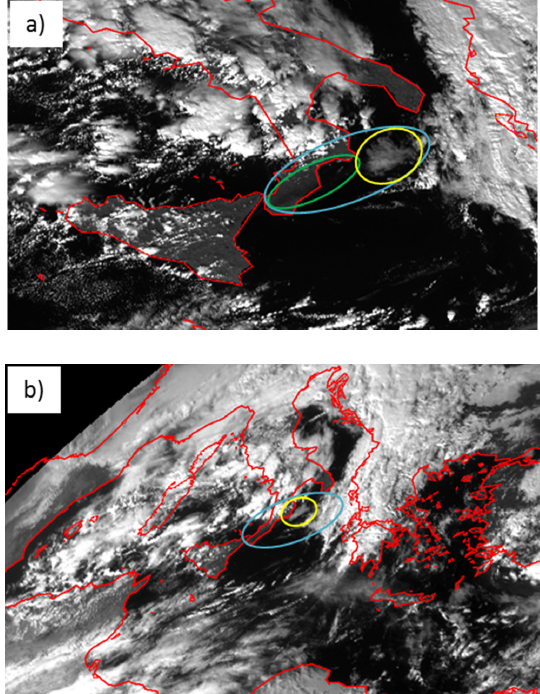
Figure 5. The Etna 23.11.2013 eruption viewed in the images collected around 11:49 UTC from ( a ) SEVIRI (9.5° E); and ( b ) MVIRI (57.5° E). The cloud of volcanic origin is marked with a blue ellipse. The cloud for which ACTH is estimated is marked in yellow. The ash cloud marked in green is not visible in the MVIRI image. The complete sequence of SEVIRI and MVIRI images is provided in the supplementary material.